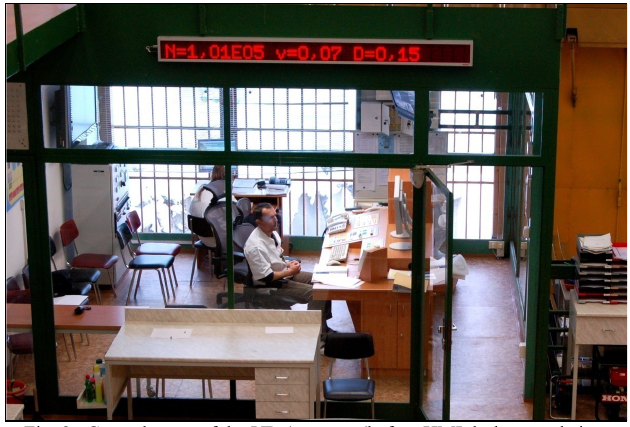
Fig. 2. Control room of the VR-1 reactor (before HMI desk upgrade in